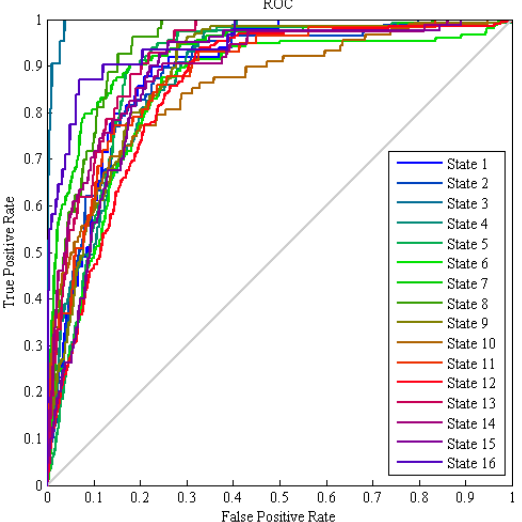
Figure 8. Receiver operating characteristic (ROC) graph of the hybrid ANN-CA classification of frames for the 16 different classes, using color features.